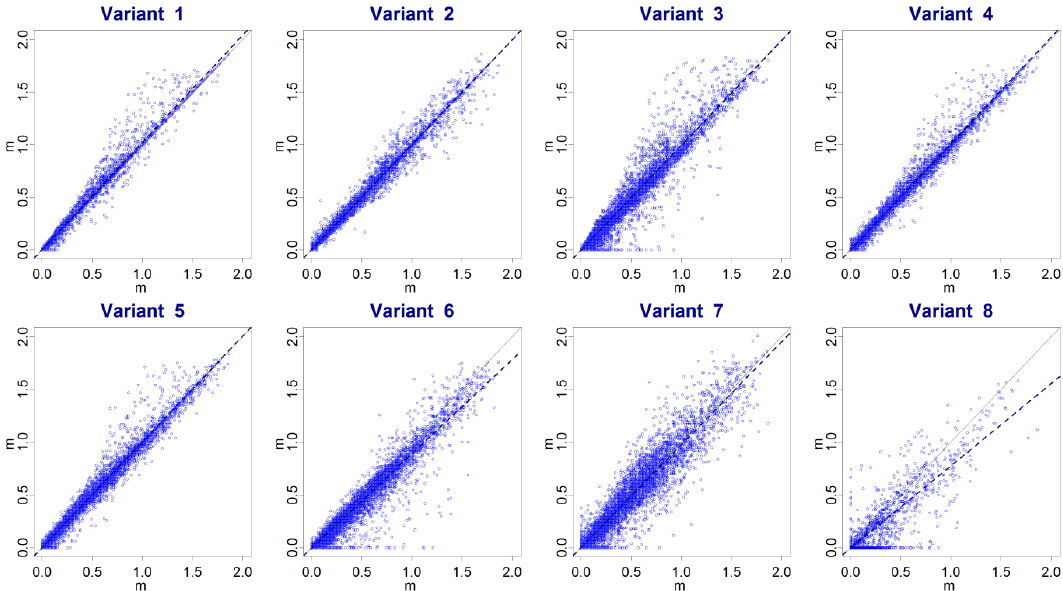
Figure 11. Monthly groundwater deficit values of the wetland sub-areas of the model variants 1 to 8 compared to the original model, variant 0 (solid line—1:1 line, dashed blue line—regression line, efficiency parameter in Table 4).